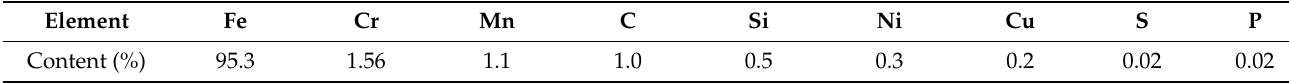
Table 1. Chemical composition of 100CrMn6 bearing steel used in testing. Element